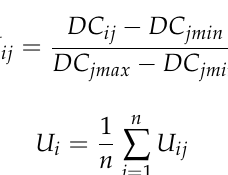
Figure S1: Maximum and minimum daily air temperature at two meters and precipitation in the 2012–2013 and 2013–2014 growing seasons. The weather data were from AgriMet Cooperative Agricultural Weather Network and National Oceanic and Atmospheric Administration, Table S1: Drought Susceptibility Index (DIS) and Membership function value of drought tolerance (MFVD) and grain yield (GY) of the 198 accessions, Table S2: The number of accessions (ACNO), name, country, state, improvement status, and maturity group of 198 winter wheat accessions, Table S3: The analysis of variance (ANOVA) of winter accessions (198 accessions and five checks in 1213IR and 1213TD, three replications in 1314TD) for the traits in three maturity groups (early, intermediate and late) in three